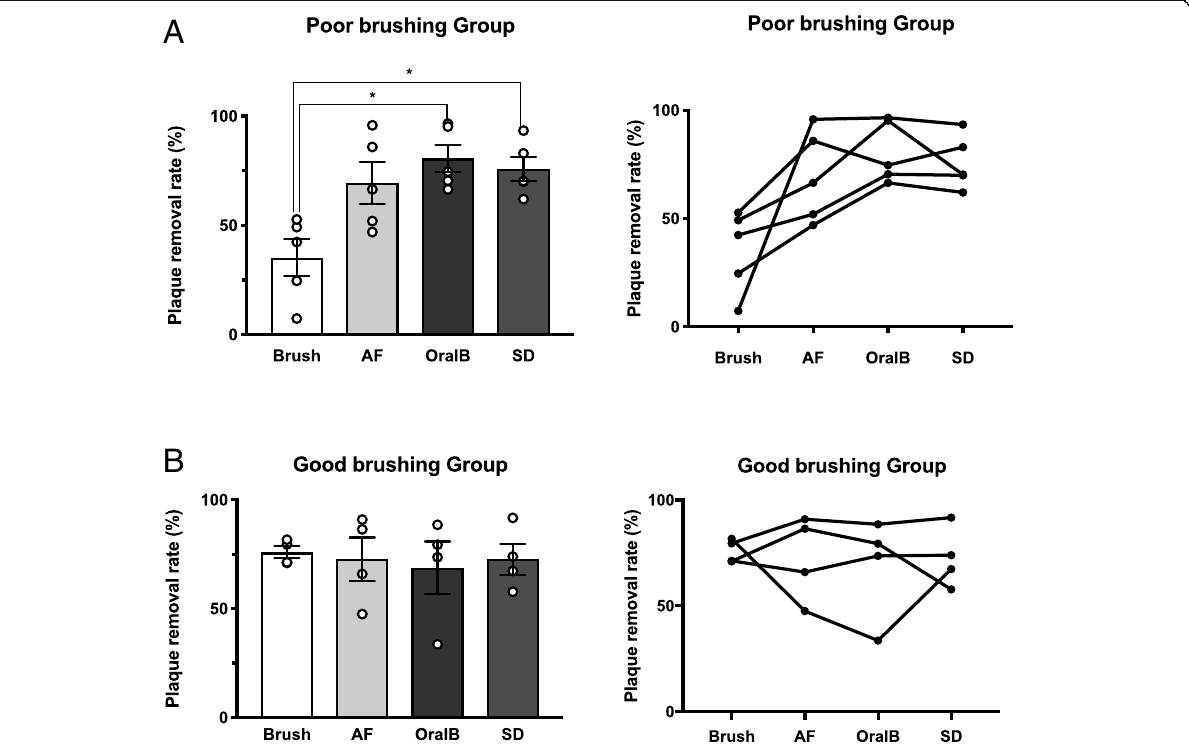
Fig. 3 Comparison of plaque removal rates among groups according to manual toothbrushing skill. a Plaque removal rates of subjects with poor brushing skills ( n = 5) improved significantly with use of electric toothbrushes, relative to the use of a manual toothbrush. b Consecutive data plots of the individual subjects represented in Fig. 2a. c Subjects with good toothbrushing skills ( n = 4) did not exhibit significant differences among cleaning instruments. d Consecutive data of the individual subjects in the good brushing group. * p <